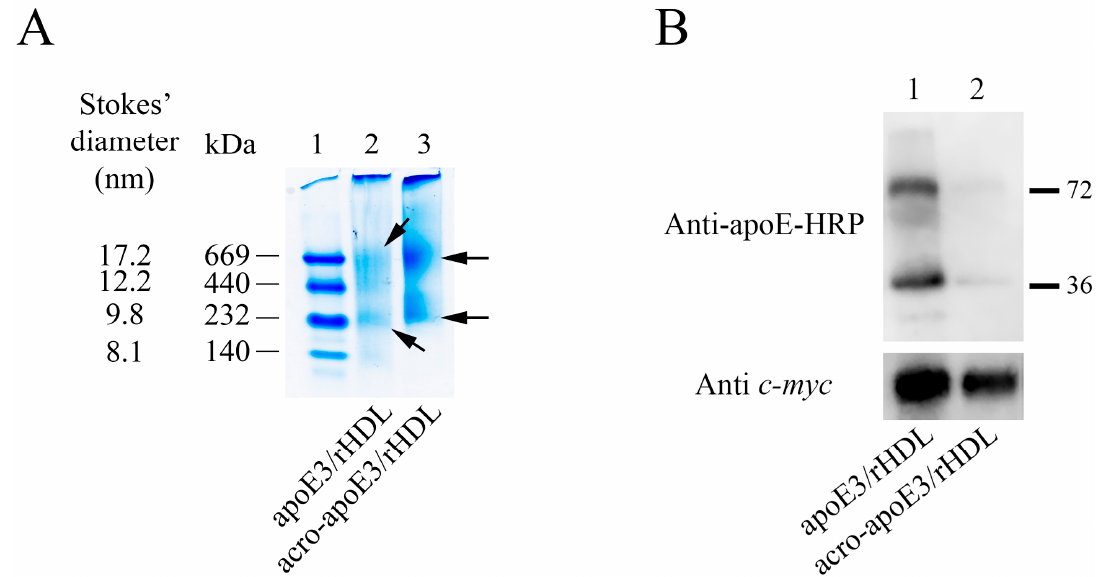
Figure 3. Characterization of lipid-associated unmodified and acro-apoE3. ( A) Non-denaturing PAGE of apoE3/rHDL and acro-apoE3/rHDL. The rHDL particles (~20 µg protein) were electrophoresed